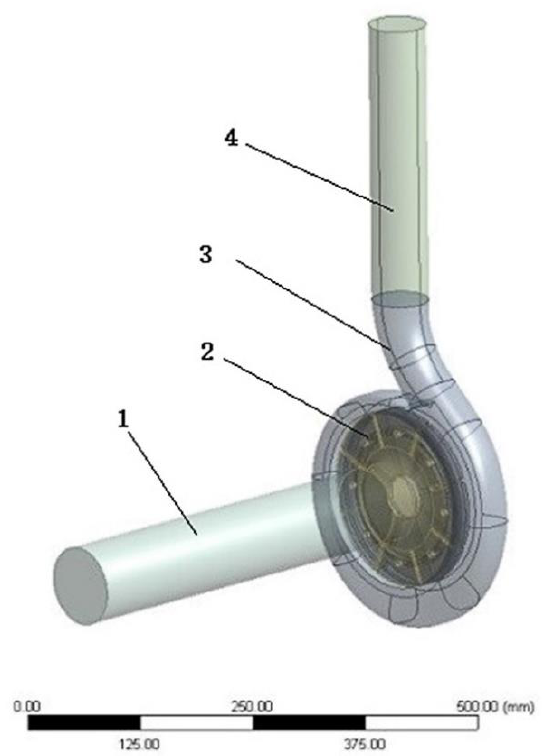
Figure 2. 3D model of disc pump flow channel with radial straight blade. 1 — inlet extension pipe; 2 — impeller; 3 — volute casing; 4 — outlet extension pipe.